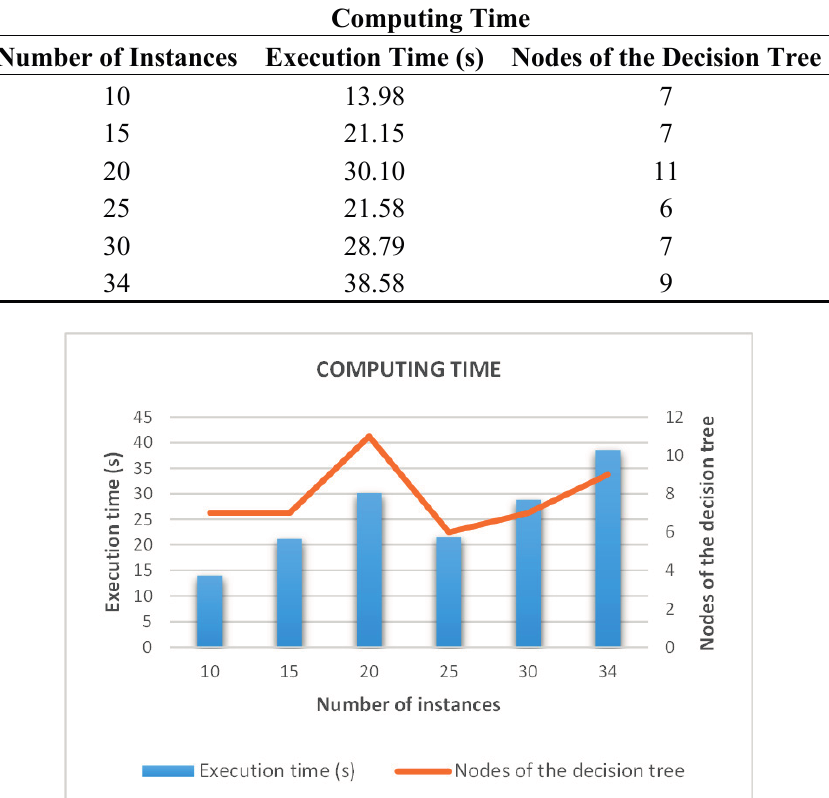
Figure 21. Computing time of the decision tree